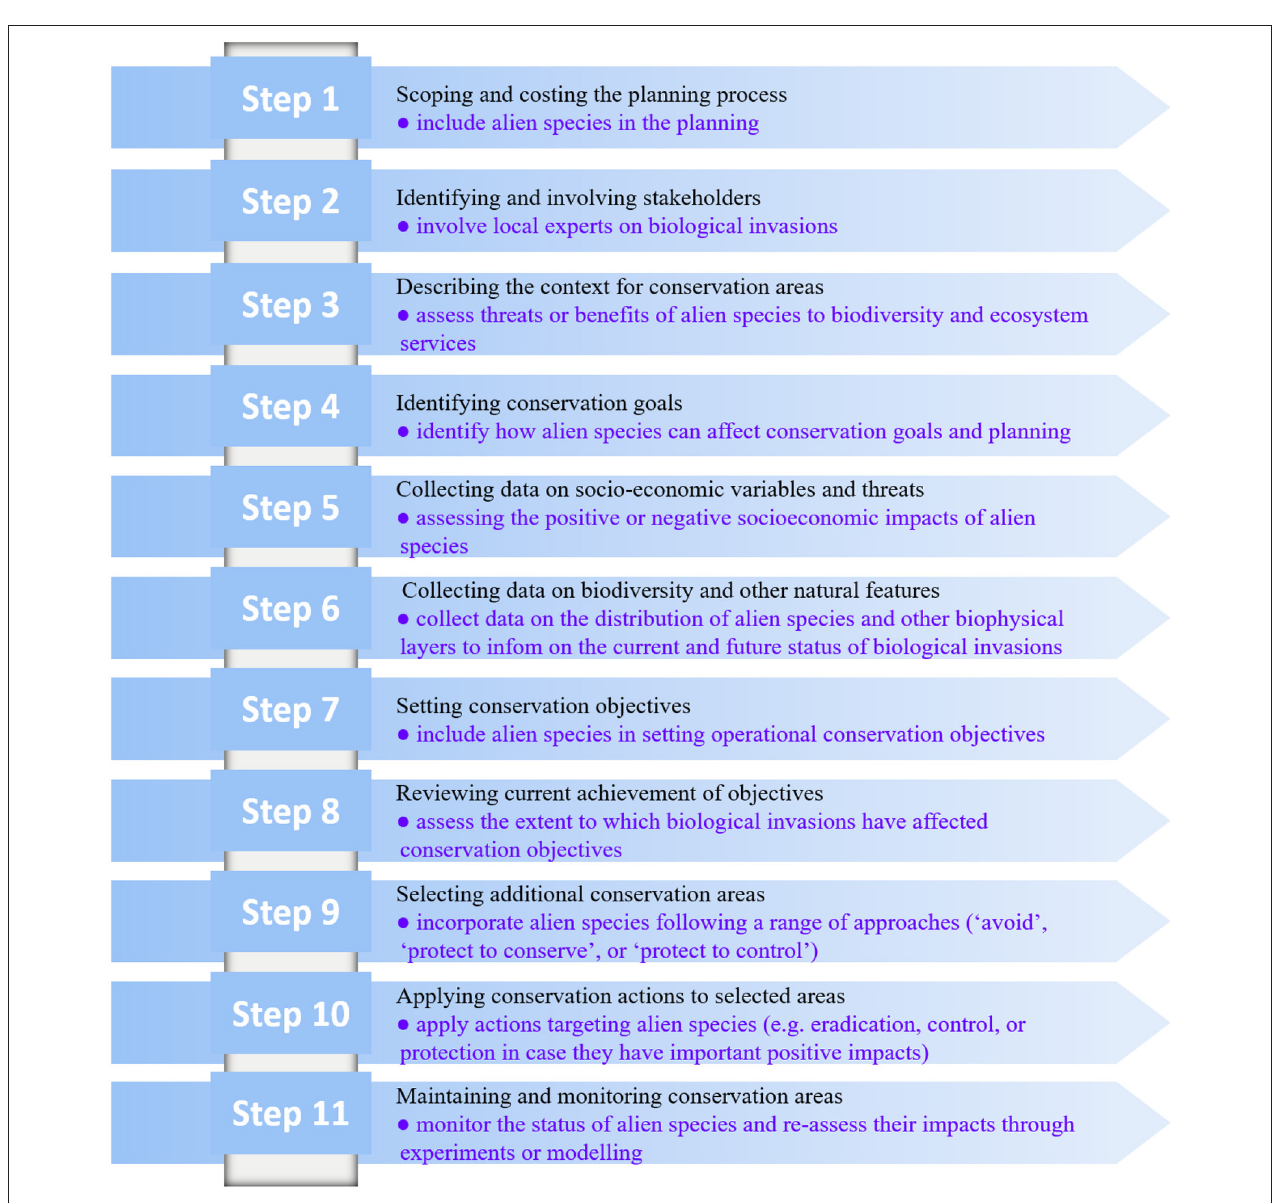
FIGURE 4 | Incorporating biological invasions in the 11-step process of conservation planning, as suggested by Pressey and Bottrill (2009). The original titles of the 11 steps are given in black, and our proposed inclusion of biological invasions at each step is given bulleted in blue.